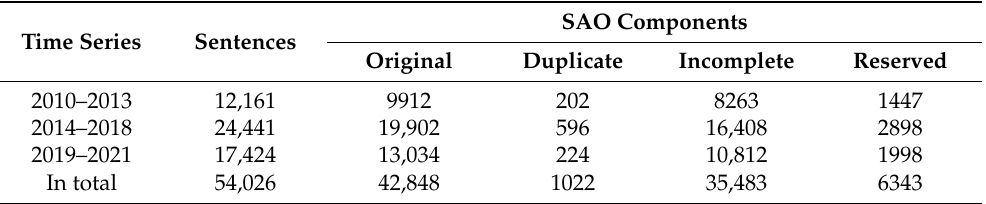
Table 2. Number of SAOs for the technology layer.